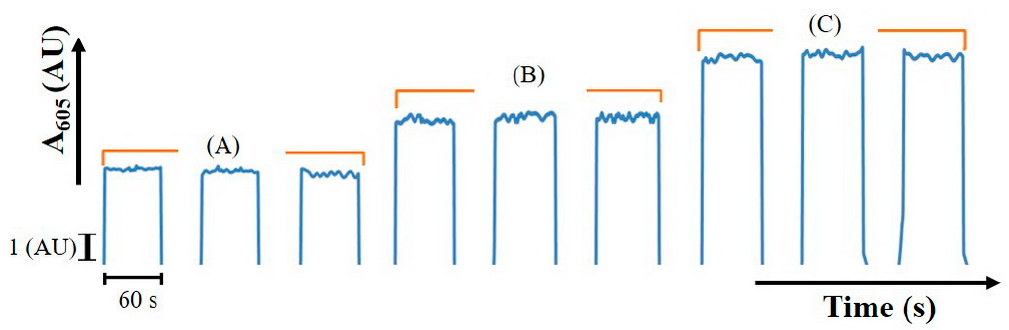
Figure 1. Analytical signal obtained from albumin content in 200 µL ( A ) 0, ( B ) 2.1, ( C ) 3.5 µg human serum albumin (HSA).